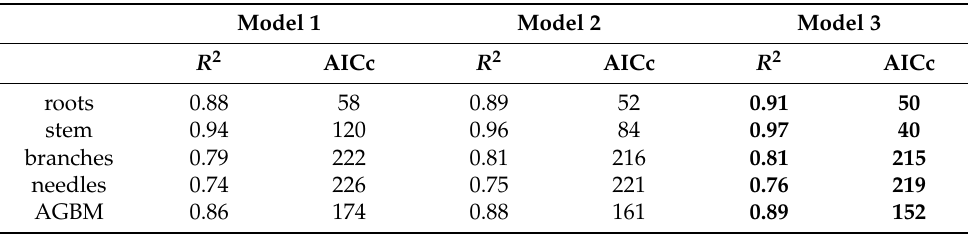
Table 2. Comparison of fitting performances ( R 2 and AICc) of the three models for needles, branches, stem, roots and aboveground biomass (AGBM) in black spruce ( n = 96) trees with height > 1.3 m. R 2 and AICc values of the best model are shown in bold for each compartment.